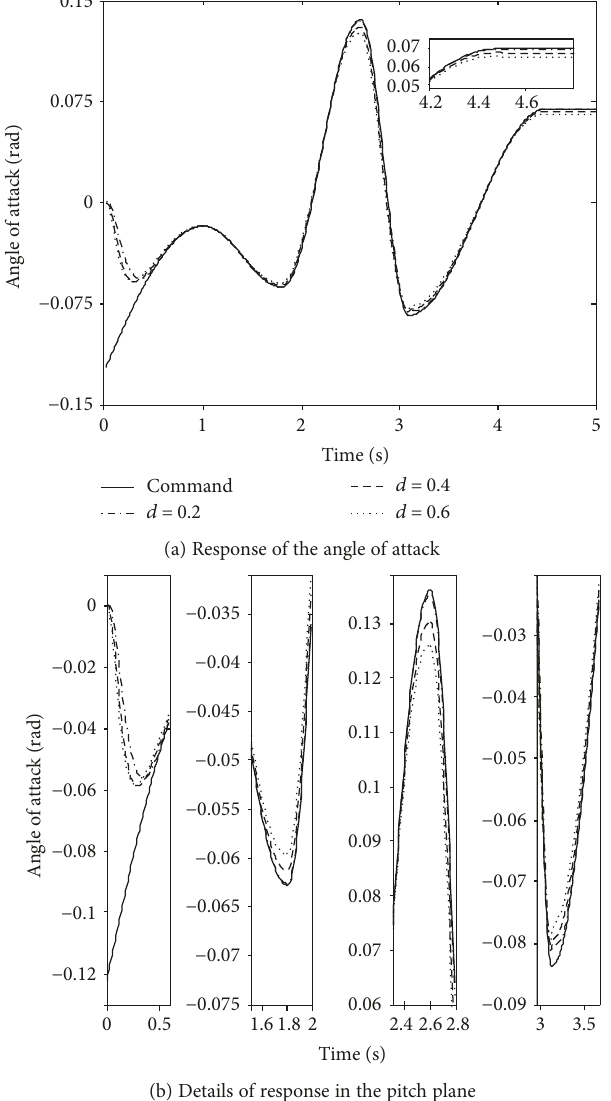
(b) Details of response in the pitch plane Figure 5: Time history of the angle of attack.